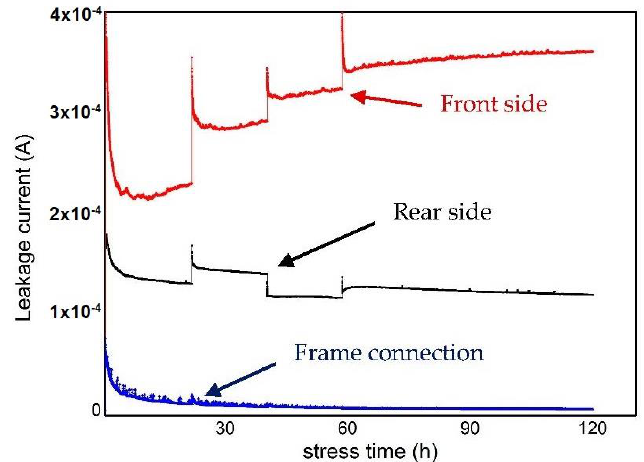
Figure 11. Leakage currents in three conditions under negative voltage: rear side, front side, and frame connection.